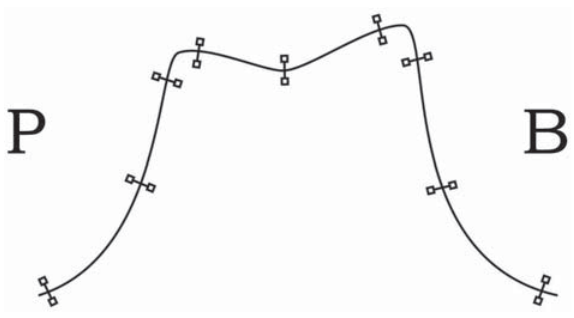
Figure 3 - Positions of the cement line